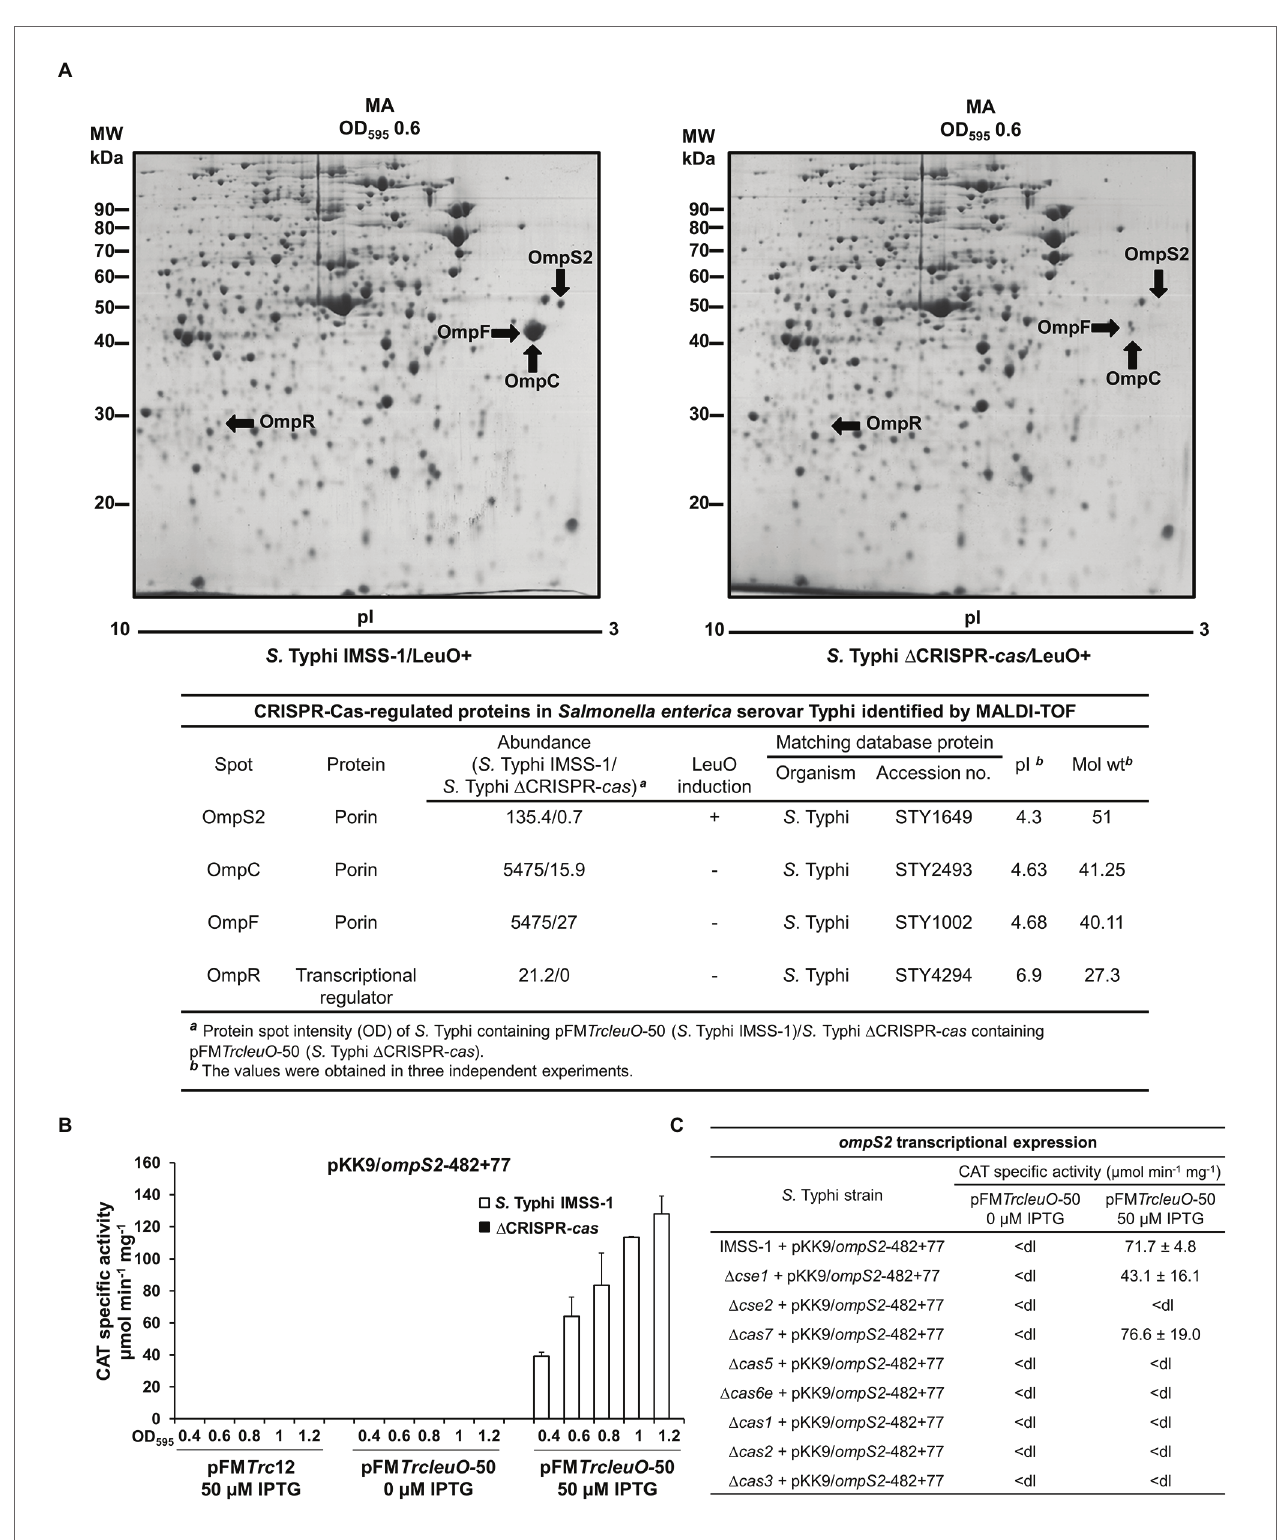
FIGURE 3 | CRISPR-Cas is essential for the synthesis of Omps2, OmpC, and OmpF in Salmonella Typhi. (A) Proteomic profiles of Salmonella Typhi total protein extracts. Salmonella Typhi IMSS-1 wild type and Salmonella Typhi Δ CRISPR- cas containing pFM TrcleuO -50 were grown in MA to an OD 595 of 0.6. Cultures